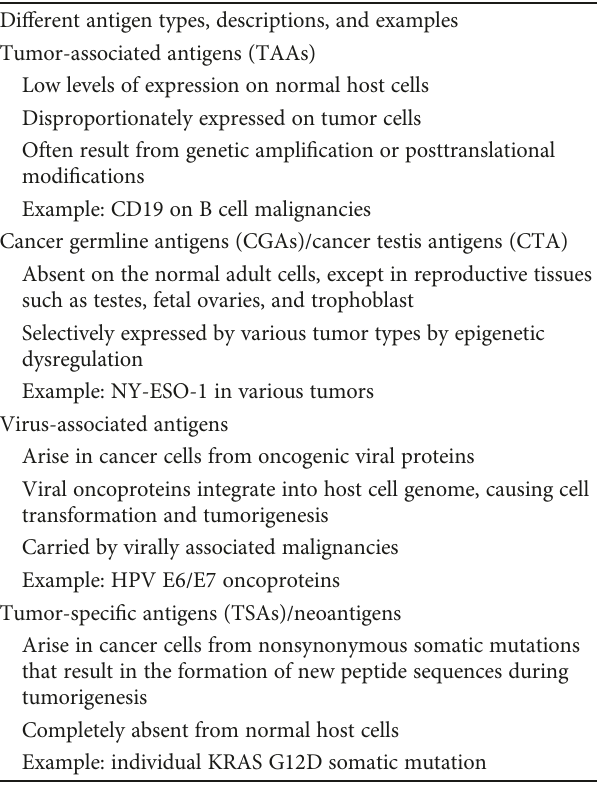
Table 1: Categories of tumor